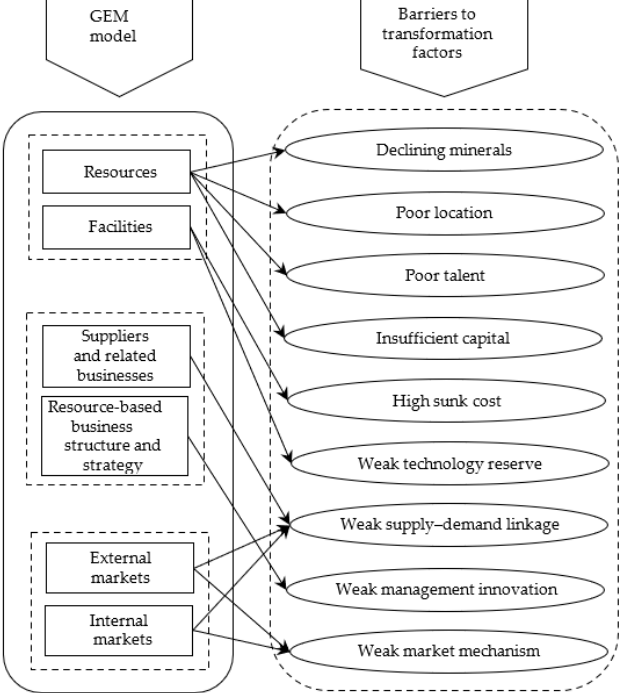
Figure 1. GEM analysis model based on resource industries’ green transformation behavioral barriers convergence chart.